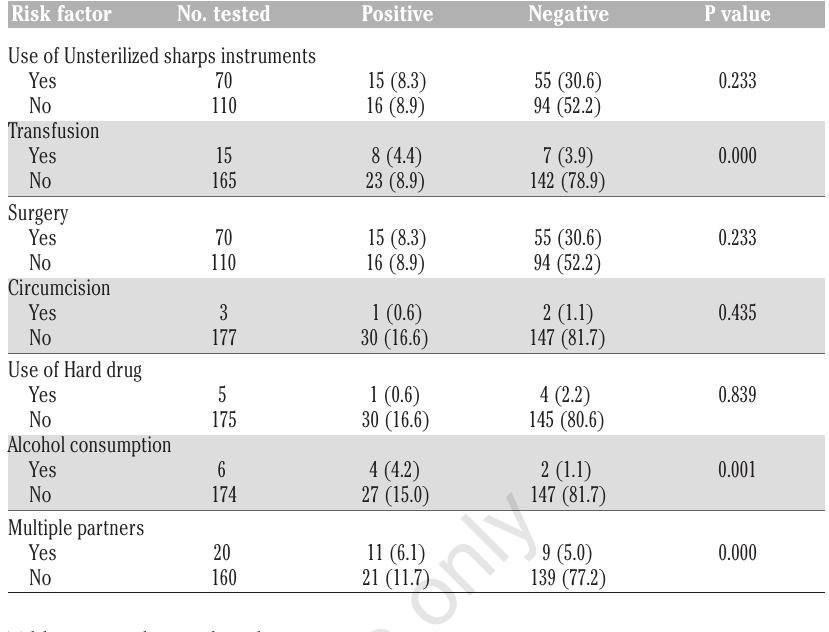
Table 4. Distribution based on risk factors.